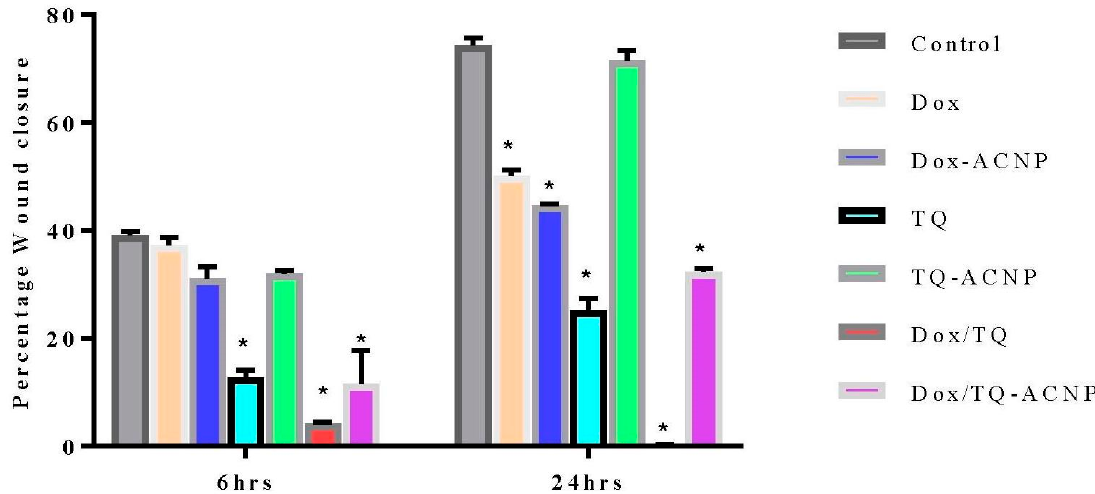
Figure 16. Graphical representation of wound closure in untreated and treated 3D mammosphere at and 24 h post scratching. * p < 0.05 compared to 6 and 24 h post scratching.* p < 0.05 compared to control.